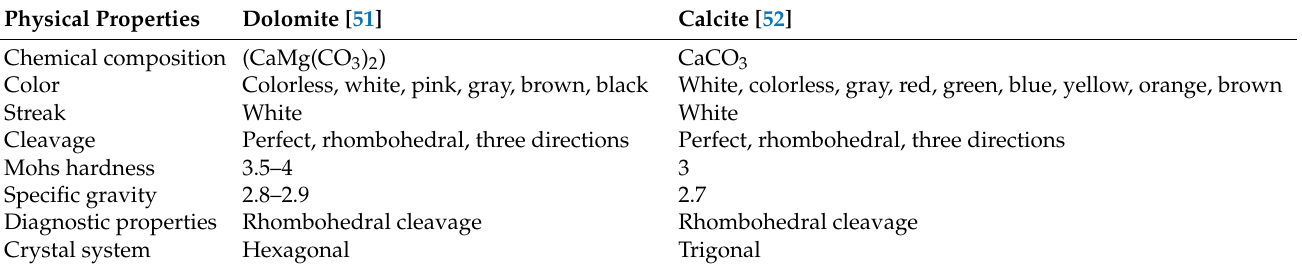
Figure 5. ( a ) Dolomite in gravel form, ( b ) dolomite in smaller granule form, and ( c ) dolomite in fine powder form.